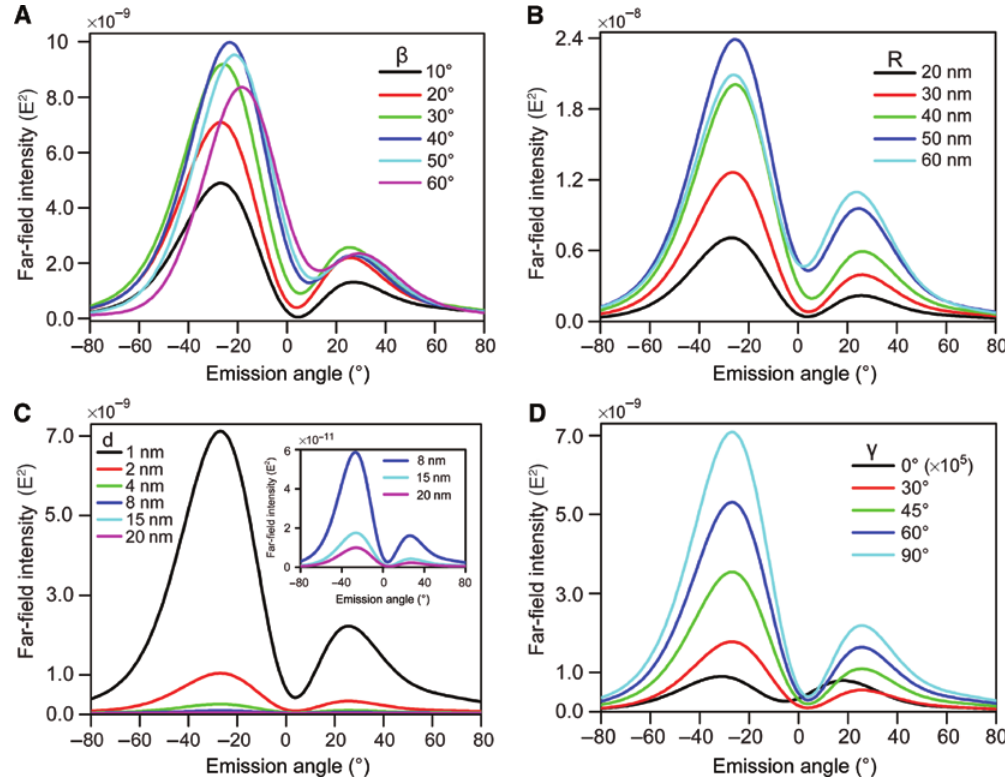
Figure 5: Calculated far-field intensity versus emission angle, cone angle, tip radius, tip-film distance and dipole orientation. The angle-resolved emission pattern of the TES at different (A) cone angles of the tip β , (B) tip radius R, (C) tip-film distance d and (D) dipole orientation γ . Inset: the enlarged image for d = 8, 15 and 20 nm in